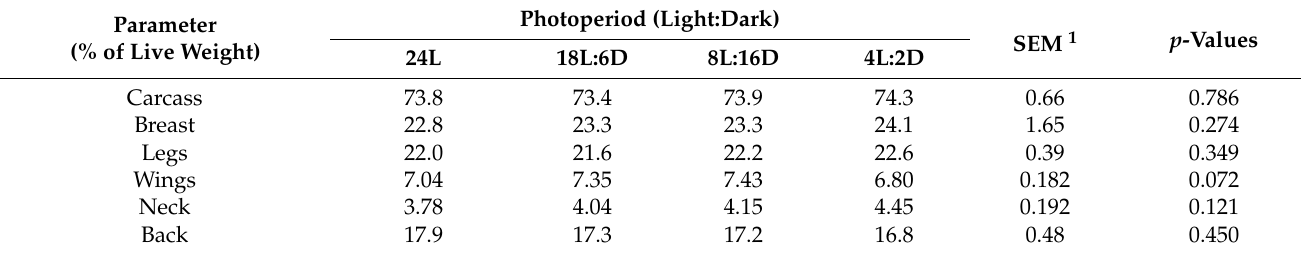
Table 7. Effect of photoperiod on carcass yields of